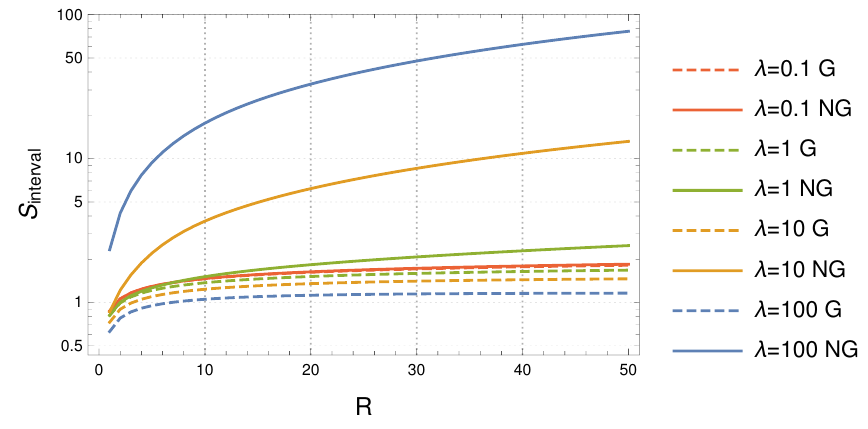
Figure 2 . Entanglement entropy of intervals as a function of the size of the intervals R for Gaussian (dashed) and non-Gaussian (solid) states. The latter are constructed through m = 2 NLCT and minimize the energy functional (4.1) for different values of λ .